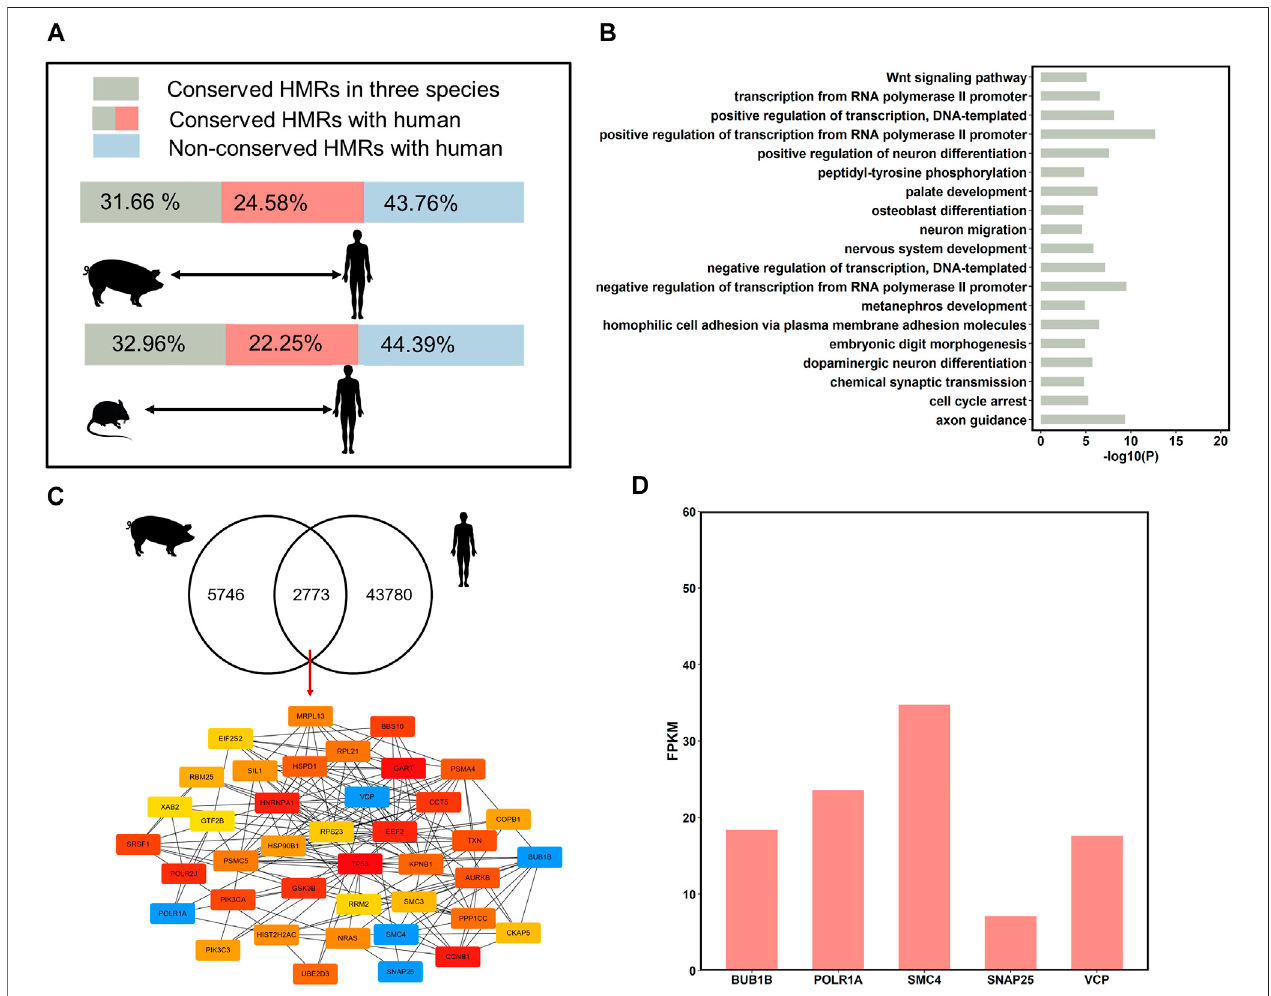
FIGURE 5 | DNA methylation conservation and divergences of species. (A) Comparison HMRs in human to pig, and mouse. The green bars correspond to the conservativeHMRpercentage ofthreespeciesinthepigandmouse. Thegreenbarsplus redbarscorrespondtothepercentage ofconserved HMRsinpigandmouse, comparedtothehuman.Theblue bars correspond tonon-conservativeHMR percentage inthepig andmouse, compared tothehuman. (B) GeneOntologyanalysisof genes associated with conserved hypomethylated ( < 20%) promoters in three species (top 20, p < 0.05). (C) The hub genes with conserved HMRs between humans and the three pigs at the promoters (top 40). (D) The expression level of the important hub genes in human sperm.